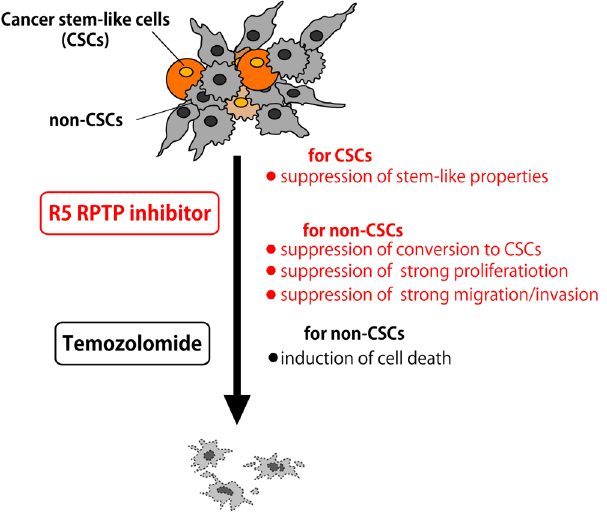
Figure 11. CSC differentiation effects of the pharmacological inhibition by R5 RPTPs. Because cancer stem- like cells (CSCs) contribute to therapeutic resistance and tumor recurrence in malignant tumors including glioblastoma 24 , a more effective therapy should target chemoresistant CSCs and proliferating and invading cancer cells. PTPRZ is strongly expressed in malignant gliomas 20, 21 , and the expression levels of PTPRZ transcripts are closely associated with cancer stemness in primary human glioblastomas 26 . The short receptor form, PTPRZ-B, is the major PTPRZ isoform in rat C6 and human U251 glioblastoma cells (Fig. 1D), the expression of which is significantly stronger in sphere-forming cells than normal cultured cells. The cell- permeable R5 RPTP inhibitor, NAZ2329, suppresses the stem cell-like properties of CSCs and the strong proliferation and migration characteristics of adherent glioblastoma cells (non-CSCs). The synergistic antitumor effects of NAZ2329 with temozolomide (TMZ) on the C6 glioblastoma xenograft, which was previously reported to be relatively resistant to TMZ (ref. 34), indicates that the combined use of R5 RPTP inhibitors and TMZ will be an effective treatment for malignant